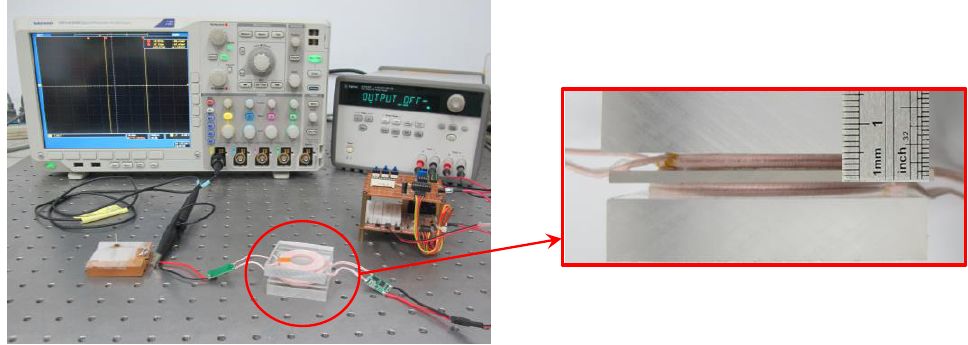
Figure 21. Photograph of the actual wireless-driven, single-phase switched reluctance motor test system.